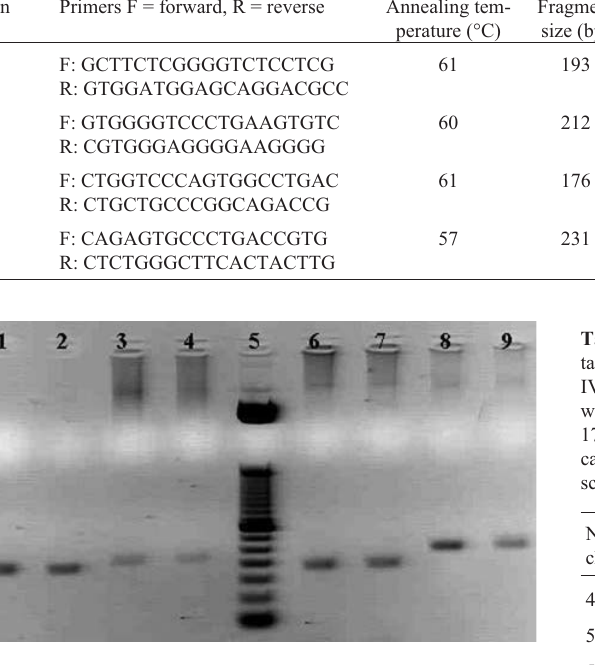
Figure 1 - PCR products on 1.5% (w/v) TBE-agarose gel: lanes 1 and 2, exon 4; lanes 3 and 4, exon 5; lane 5, 50 pb DNA ladder; lanes 6 and 7, exon 9; and lanes 8 and 9, exon 10.